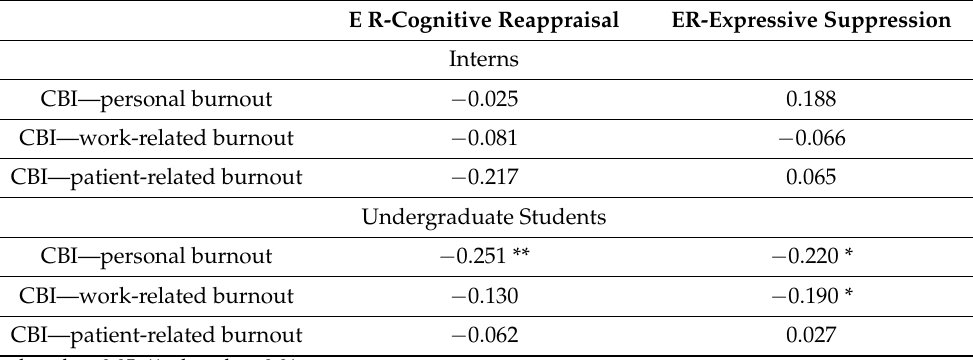
Table 2. Correlation of emotional regulation with burnout scores among interns and undergradu- ate students. E R-Cognitive Reappraisal ER-Expressive Suppression